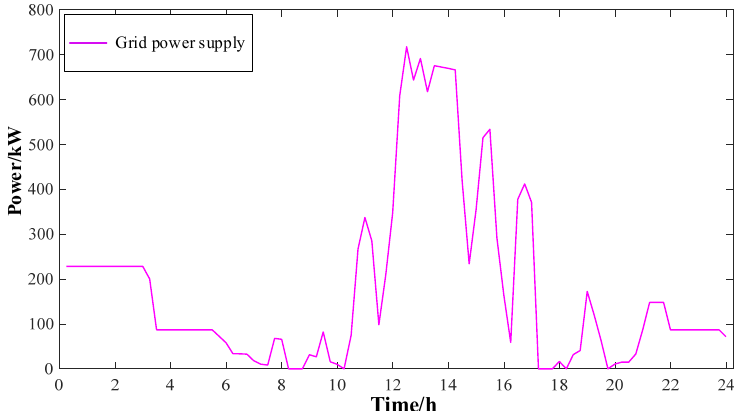
Figure 7. Power curve of grid supply in Scenario I.